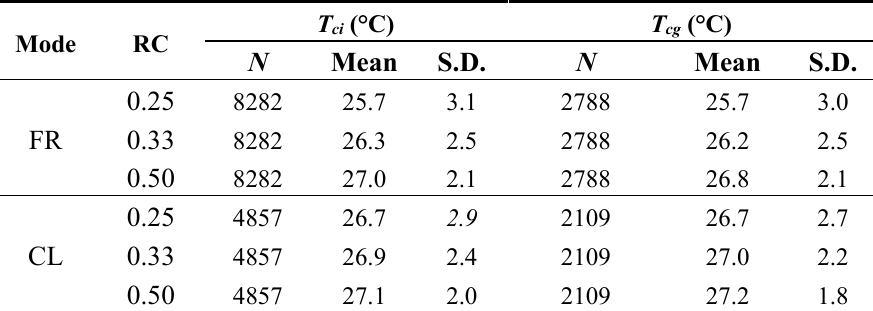
Table 8. Comfort temperature predicted by Griffiths’